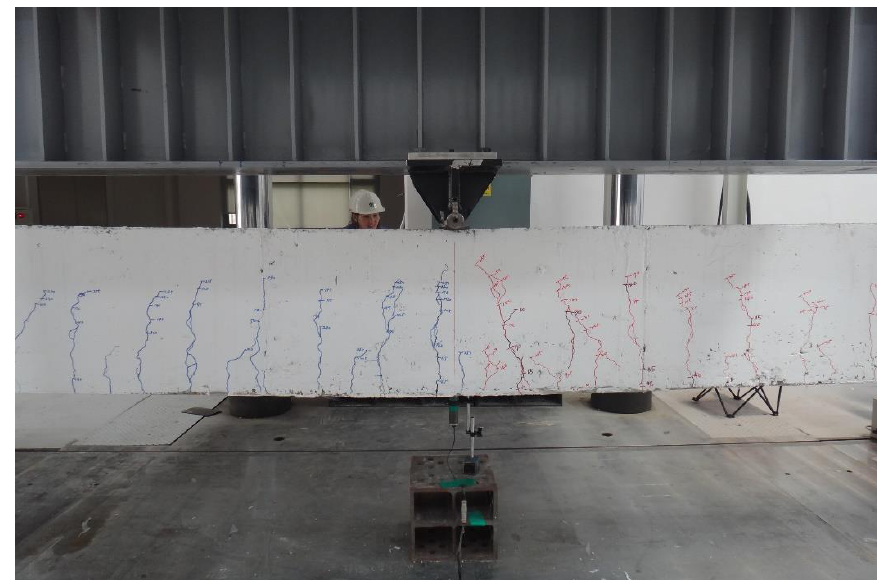
Figure 3. The short-term test on the reinforced concrete (RC) beam specimen.